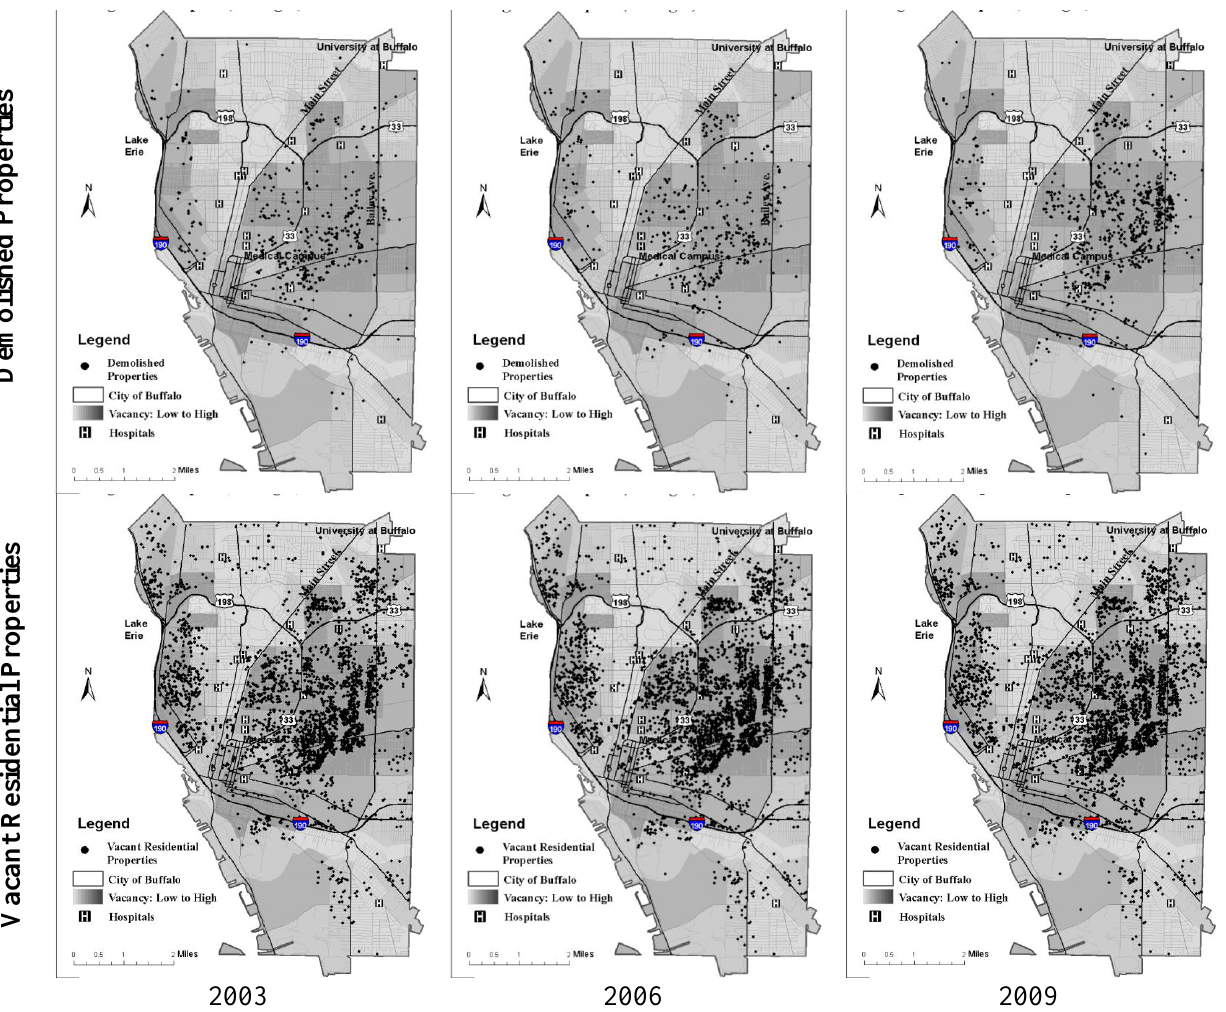
Figure 1. Vacant residential properties and demolished properties in Buffalo, NY: 2003, 2006,